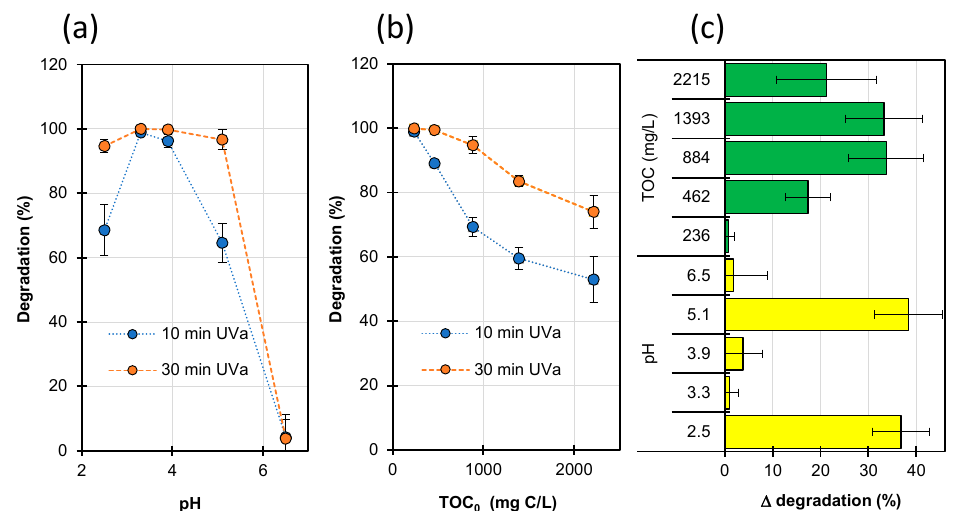
Figure 4. Effect of pH ( a ) and TOC ( b ) on STZ degradation and difference ( ∆ ) in the degree of degradation of Fenton and photo-Fenton processes after 30 min ( c ). [STZ] 0 = 0.1 mmol/L, [FeSO 4 ] 0 = 0.15 mmol/L, [H 2 O 2 ] 0 = 20.0 mmol/L.